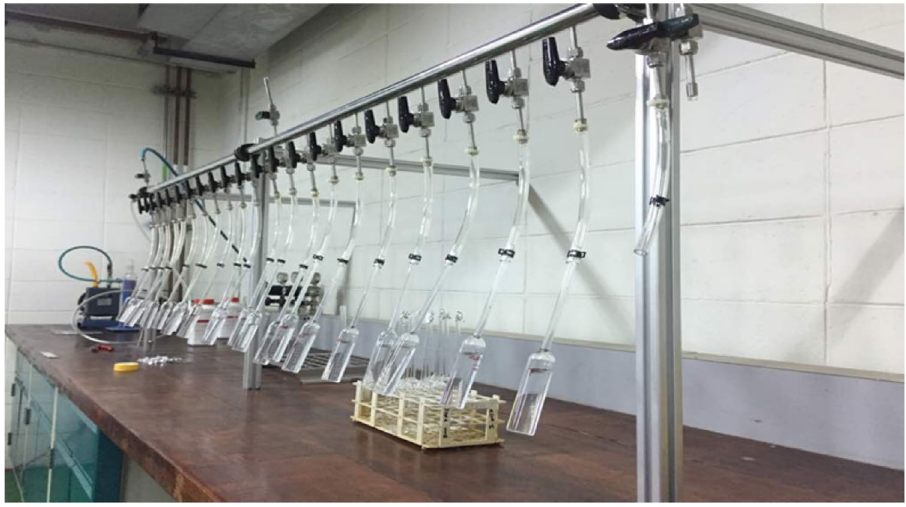
Fig. 5 Vacuum and nitrogen purging setup for fire